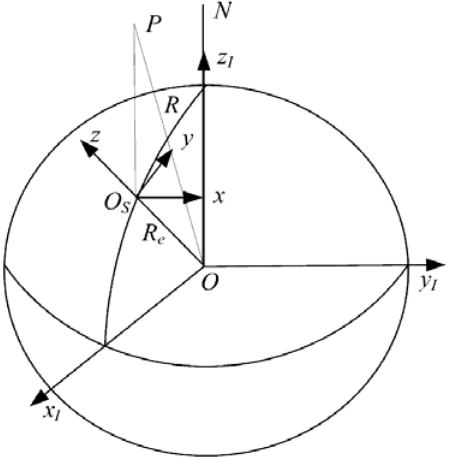
Figure 5. Geometry of radar and